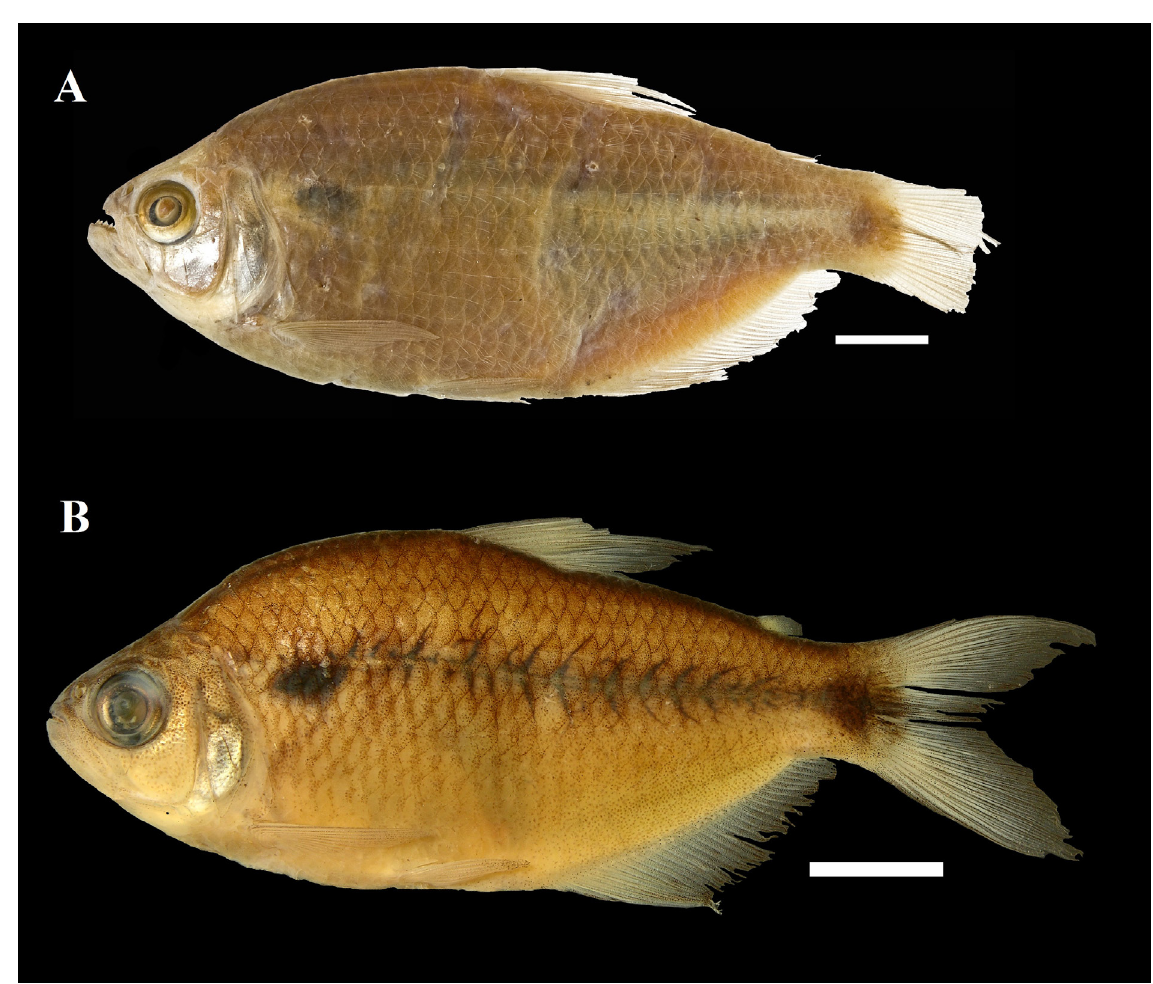
Fig. 8. Astyanax orthodus Eigenmann, 1907. A . Holotype, 88.3 mm SL, Truando River, Atrato River Basin, Chocó, Pacific coast of Colombia (USNM 55655). B . 32.5 mm SL, Vereda Sautatá, Atrato River drainage, Chocó, Pacific coast of Colombia (IAVH 7146). Scale bars = 1